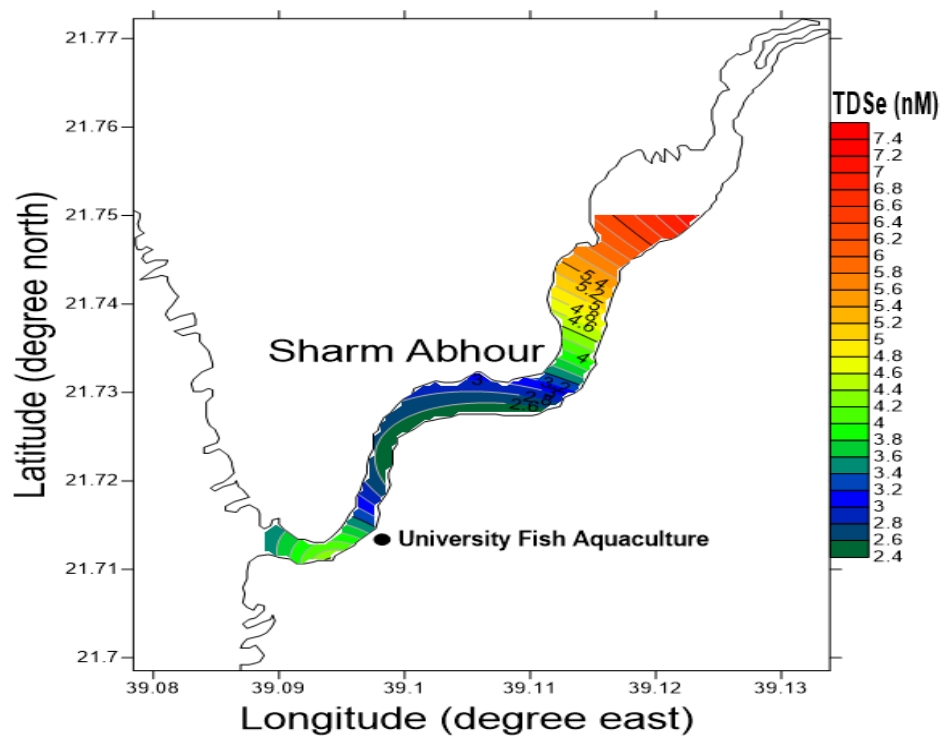
Figure 8. Total dissolved selenium horizontal distribution along the Sharm Obhur surface water.